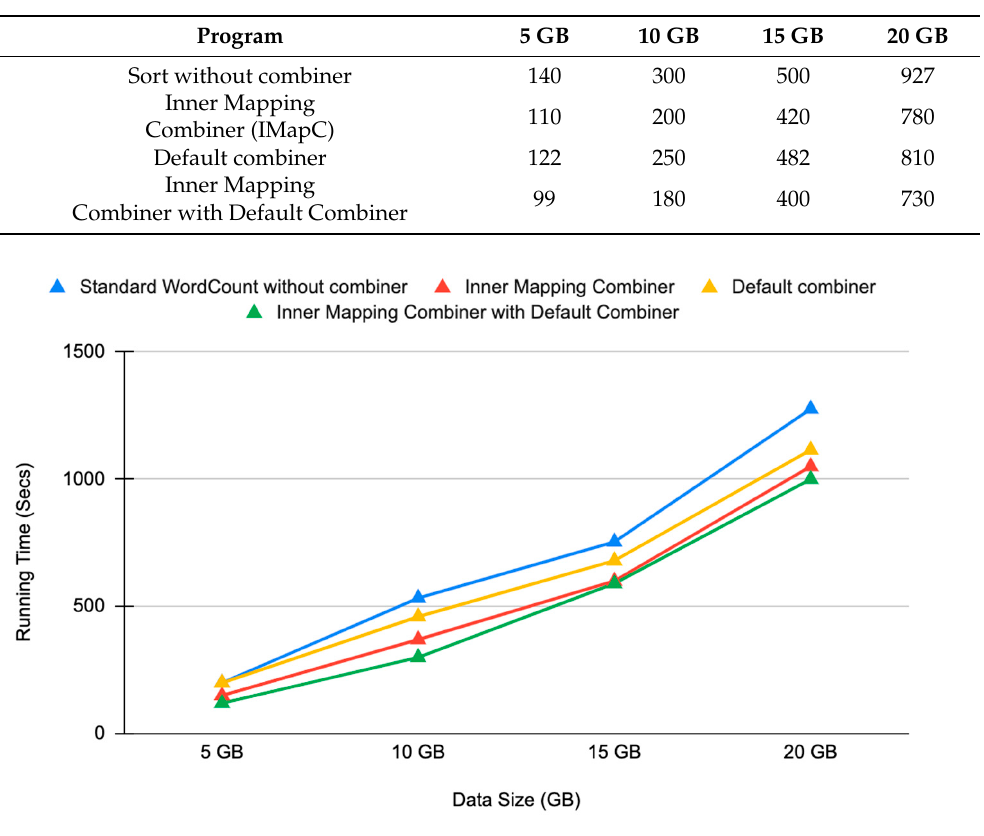
Figure 5. Execution time of Sort program for Inner Mapping Combiner (IMapC) over the Default Combiner and without the Combiner in Standard Hadoop. 4.2. Performance Comparison of IMapC in TFR Tables 4 and 5 show the performance comparison results on running WordCount and Sort benchmarks in TFR. Figures 6 and 7 show the execution time of the WordCount and Sort program compared with the Inner Mapping Combiner (IMapC) over Default Com- biner and without Combiner for TFR. Figures 8 and 9 show the execution time of Word- Count and Sort programs for TFR with IMapC compared with TFR and Hadoop with IMaPC. Tables 6 and 7 show the performance comparison of TFR, TFR with DC of IMapC, and Hadoop on the running WordCount program. TFR with DC of IMapC can achieve the performance gain of 10 and 60% execution time compared to TFR and Hadoop with IMapC on the running WordCount program. For the Sort program, TFR with DC of IMapC speeds up the execution time by 15 and 65% on the running Sort program. Hence, the proposed method shows better results compared to the standard framework.